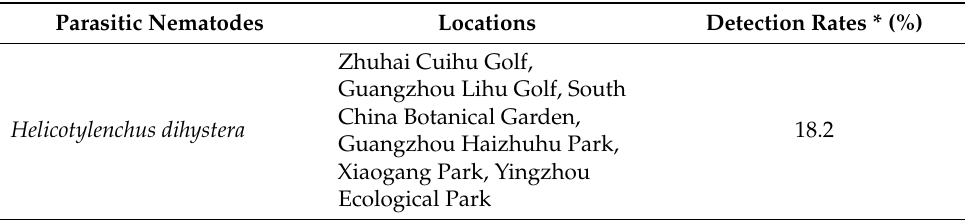
Table 3. Prevalent species of plant-parasitic nematodes in soil samples from rhizosphere of turf grasses in Guangdong,